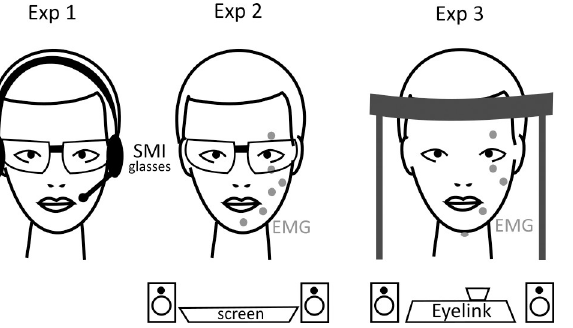
Fig 1. Experimental setup for the three experiments. In experiment 1, we recorded eye movements with SMI eye tracking glasses. In experiment 2, we added EMG and in experiment 3, we used an Eyelink eye tracker and EMG.